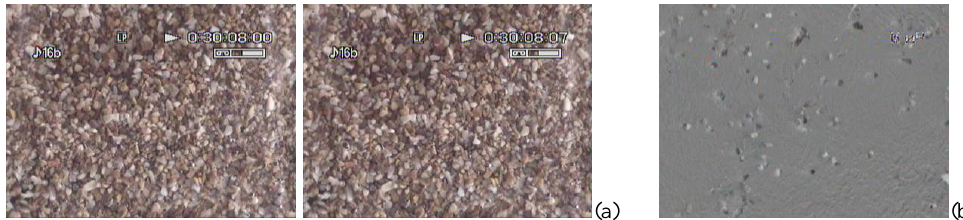
Fig. 9. Two samples of sequential captured images with the difference image between two sequential images.